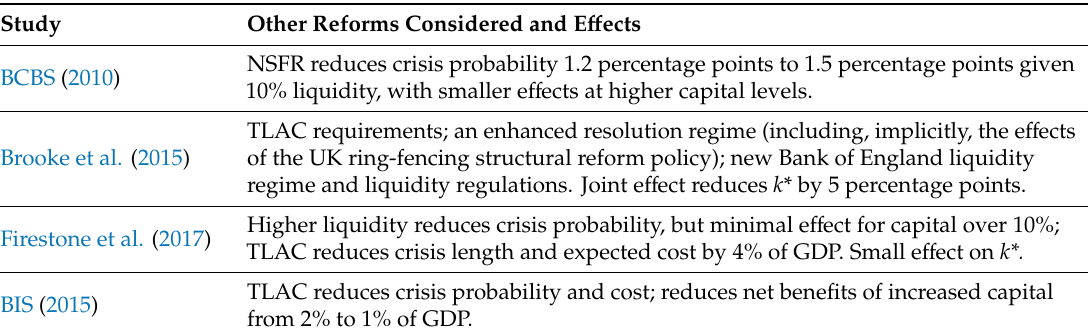
Table 3. Non-capital bank reforms in LEI